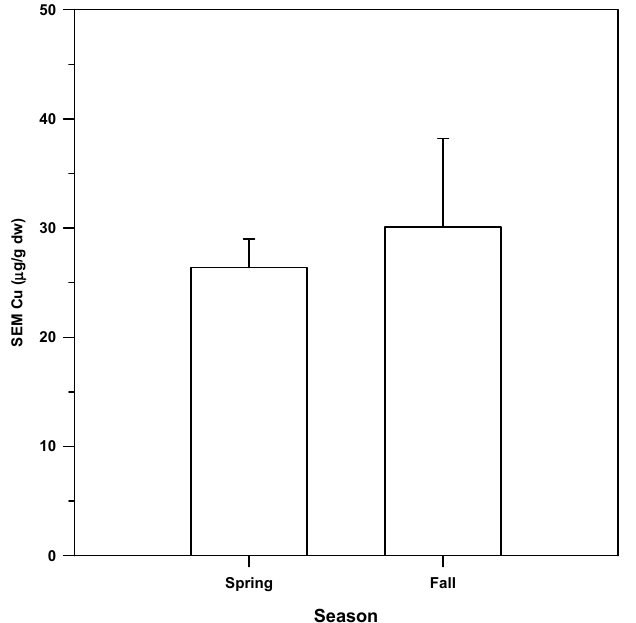
Figure 19. All Cache Slough SEM Cu sediment data for the year 2012 by season (Mann-Whitney Rank Sum Test, p = 0.402).